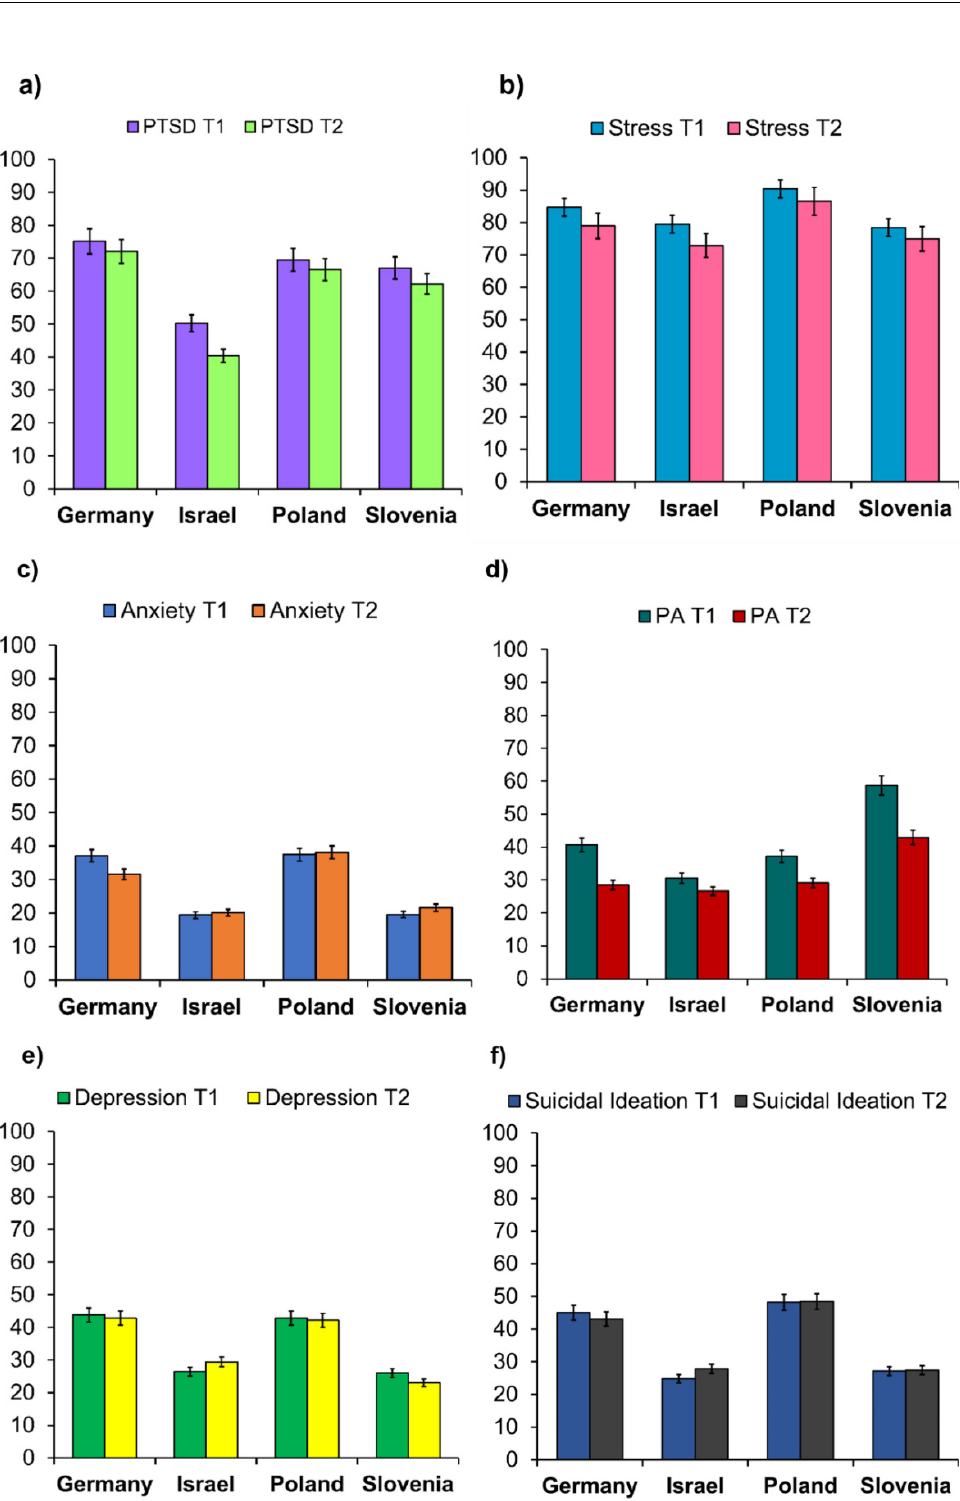
Figure 2. Percentage of young adults with: ( a ) coronavirus-related post-traumatic stress disorder (PTSD) risk; ( b ) perceived stress (PSS-10); ( c ) anxiety risk (GAD-7); ( d ) insufficient level of physical activity (PA < 150 min per week); ( e ) depression risk (PHQ-9); and ( f ) suicidal/self-harm ideation (Question 9 of the PHQ-9). Error bars are 95% of the confidence interval.